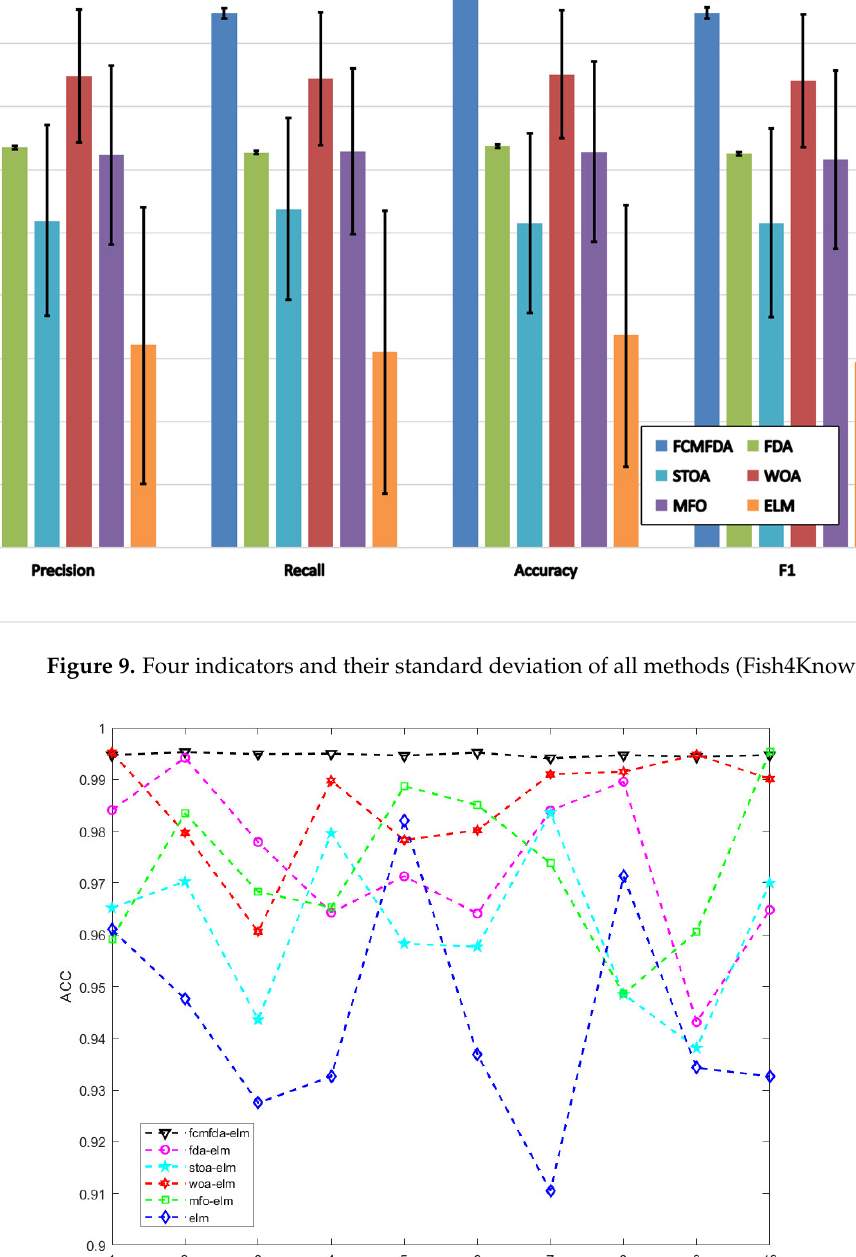
Figure 10. Ten-fold test set classification accuracy of each algorithm (Fish4Knowledge).